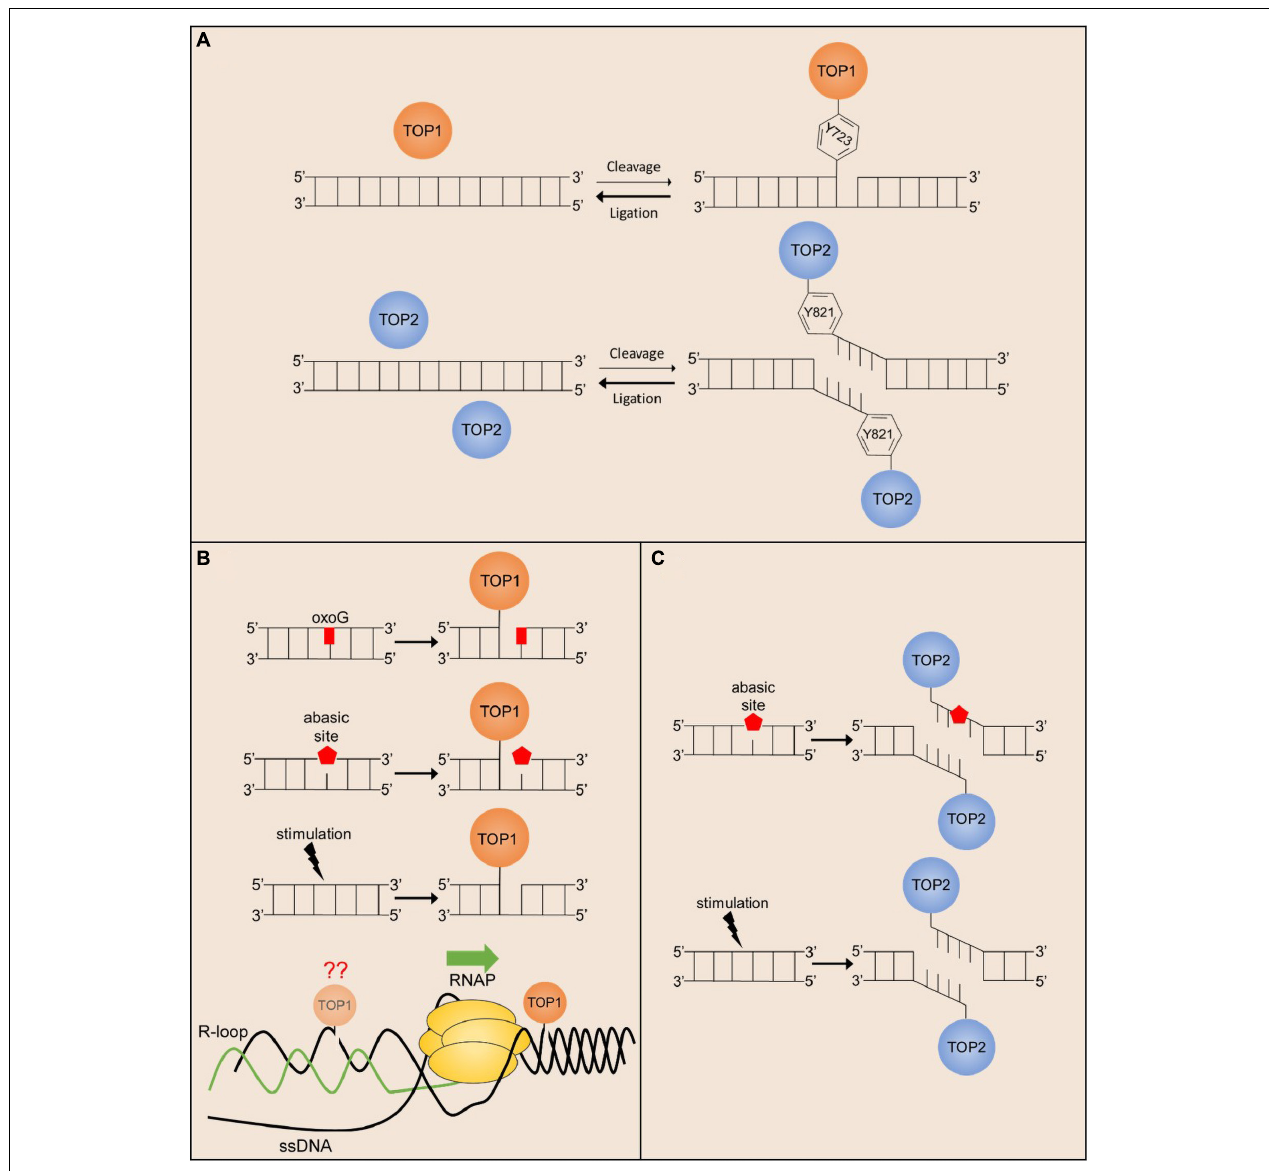
FIGURE 1 | Endogenous mechanisms of stalled TOP1 and TOP2 cleavage complex formation. (A) The cleavage/ligation reaction of TOP1 (monomer) and TOP2 (homodimer) greatly favors ligation over cleavage. Active site amino acid positions are given for hTOP1 and hTOP2B. (B) TOP1cc religation is prevented in the presence of oxidated bases and abasic sites, and the formation of TOP1-mediated SSBs can be facilitated in response to ligand-dependent stimulation. TOP1 acting in front of the polymerase can also stall transcription promoting R-loop formation, but TOP1 may also act behind the polymerase where R-loop formation can prevent TOP1cc religation. (C) TOP2cc religation is prevented in the presence of abasic sites, and the formation of TOP2-mediated DSBs can be facilitated in response to cell stimulation.